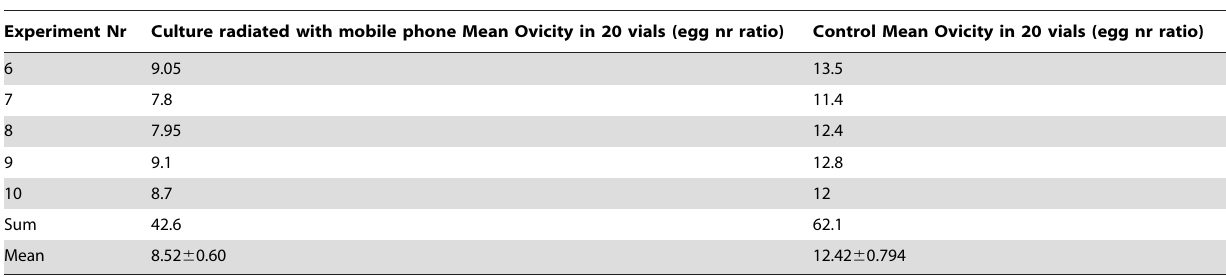
Table 2. Experimental results from cultures exposed to near field of a second generation mobile phone (900 MHz) p =0.0090 between control and mobile phone radiated